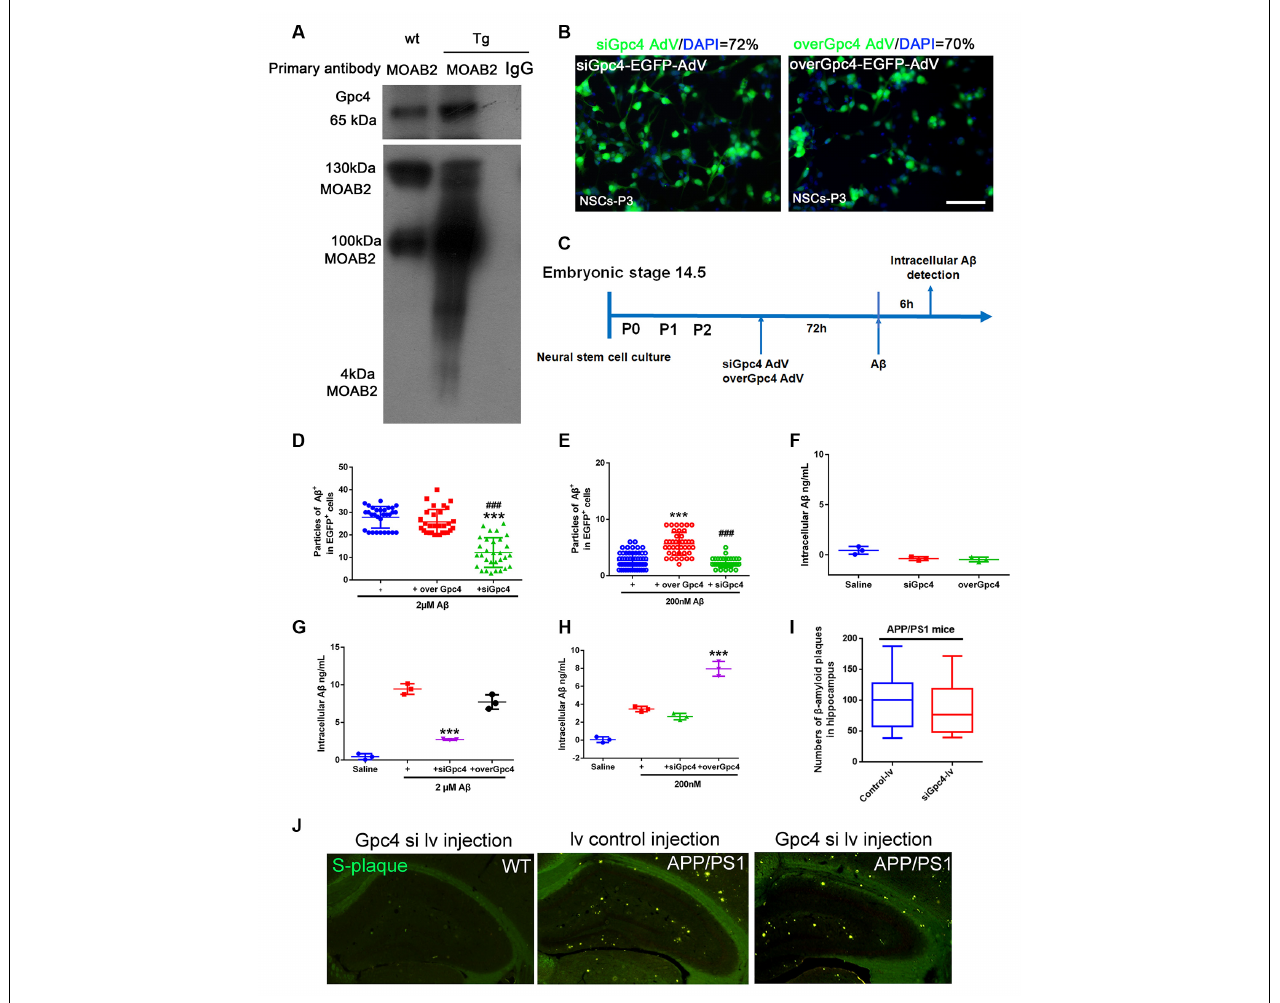
FIGURE 4 | Gpc4 regulates A β internalization in NSCs. (A) Co-immunoprecipitation result from protein lysis extracted from 6-month-old APP/PS1 mice. Protein samples were incubated with the primary antibody MOAB2. Protein complexes able to bind to MOAB2 (A β 42) were eluted. Western blotting was used to detect MOAB2 (A β 42) and Gpc4 expression. (B) NSCs were plated in complete medium, and 2 × 10 12 siGpc4 and overGpc4 AdV expression using enhanced green fluorescent protein (green) was added for 24 h. The medium was changed to complete medium, and cells were incubated for 48 h. Nuclei were marked with DAPI (blue). The ratio for AdV infection was calculated. (C) The schedule of virus infection and A β treatment on NSC cells. Seventy-two hours after virus infection, A β was added. Six hours after adding cy3-A β , all particles in AdV-positive cells were counted and compared among groups. (D) Six hours after adding 2 µ M cy3-A β , all particles in AdV-positive cells were counted and compared among groups. *** represents siGpc4 + 2 µ M A β vs. 2 µ M A β , P < 0.0001, ### represents siGpc4 + 2 µ M A β vs. overGpc4 + 2 µ M A β , P < 0.0001. (E) Six hours after adding 200 nM cy3-A β , all particles in AdV-positive cells were counted and compared among groups. *** represents overGpc4 + 200 nM A β vs. 200 nM A β , P < 0.0001, ### represents siGpc4 + 200 nM A β vs. overGpc4 + 200 nM A β , P < 0.0001. (F) AdV was used to infect NSCs, and intracellular A β 42 in NSCs was detected using ELISA. (G) NSCs were treated as previously described in (C) . Instead of cy3-A β , the A β 42 were used in this experiment. Six hours after adding 2 µ M A β 42, A β 42 levels were detected using ELISA. *** represents siGpc4 + 2 µ M A β vs. 2 µ M A β , P < 0.0001. (H) NSCs were treated as previously described in (G) . Six hours after adding 200 nM A β 42, A β 42 levels were detected using ELISA. *** represents overGpc4 + 200 nM A β vs. 200 nM A β , P < 0.0001. (I,J) siGpc4/overGpc4 lentivirus was injected into both lateral ventricles and the hippocampus of 4-month-old (APP/PS1) mice. Two months after lentivirus injection, mice were sacrificed for Thioflavin staining. β -amyloid plaques were stained in green. All particles were